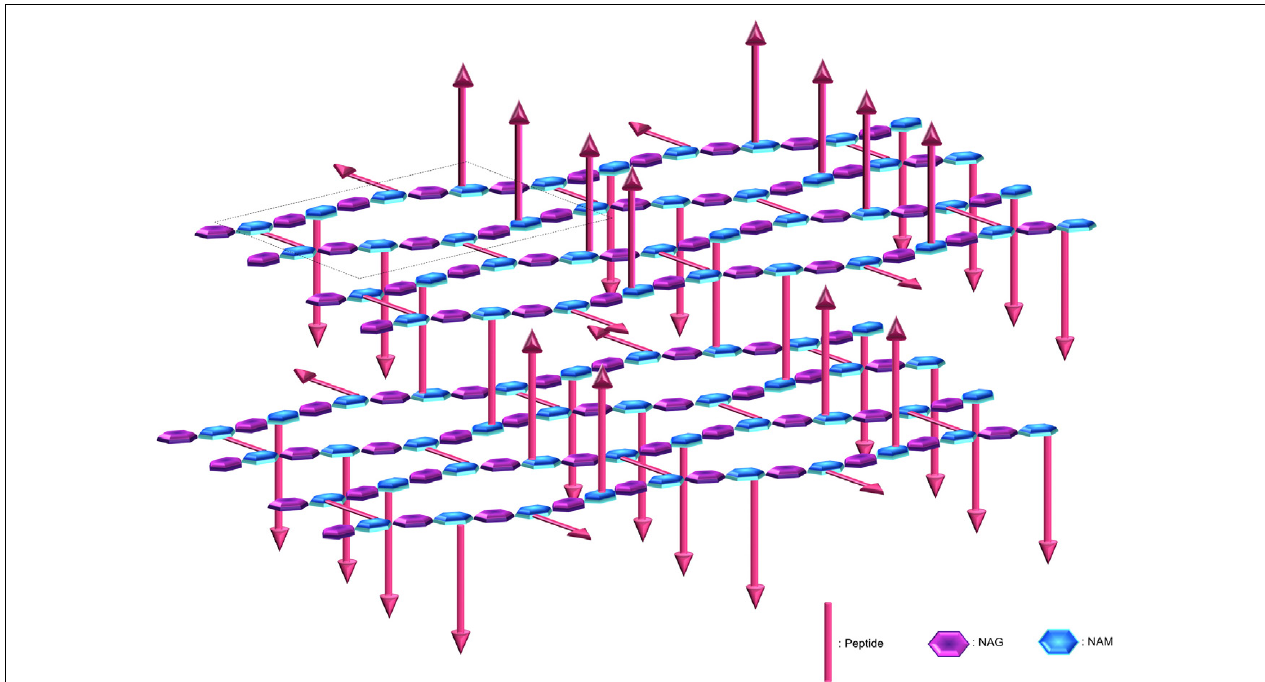
FIGURE 3 | Peptidoglycan organisation at the cell wall. The peptidoglycan is composed of N -acetylglucosamine (NAG) and N -acetylmuramic acid (NAM) linked by β -1,4 bonds, where the NAM are further crosslinked via octapeptides either at the same plane or with the upper or lower layer (arrows represent peptides protruding up or down). The peptidoglycan is tiled with hexagonal tesserae, which constitute the structural unit of the CW fabric (one basic unit constituting a tessera is displayed inside the dotted frame). Two layers of tesserae are here schematically represented to highlight the network form by the peptide crosslinking. Of note, defects due to abnormal tesserae with more edges and larger area can also occur and resulting in the increase in porosity.